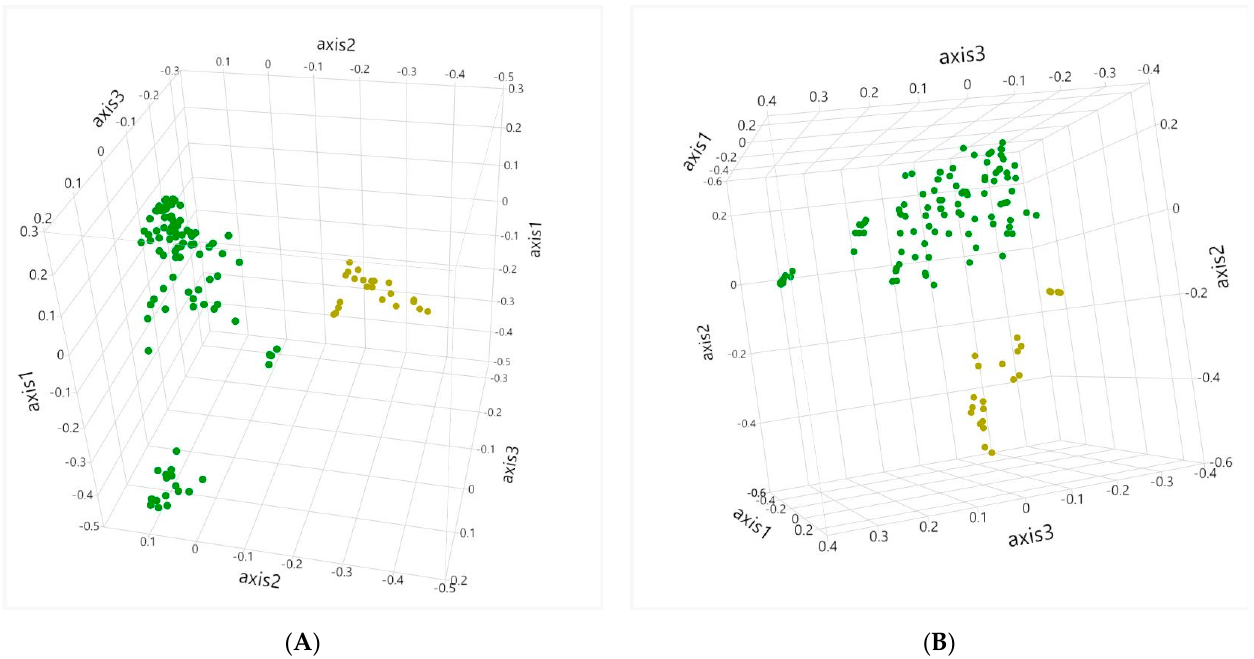
Figure 3. Beta diversity indices represented by 3D PCOA graphs. ( A ) Jaccard index and ( B ) Bray– Curtis index of cecal fluid samples (green) and fecal inoculum samples (yellow) maintained in vitro over 48 h.